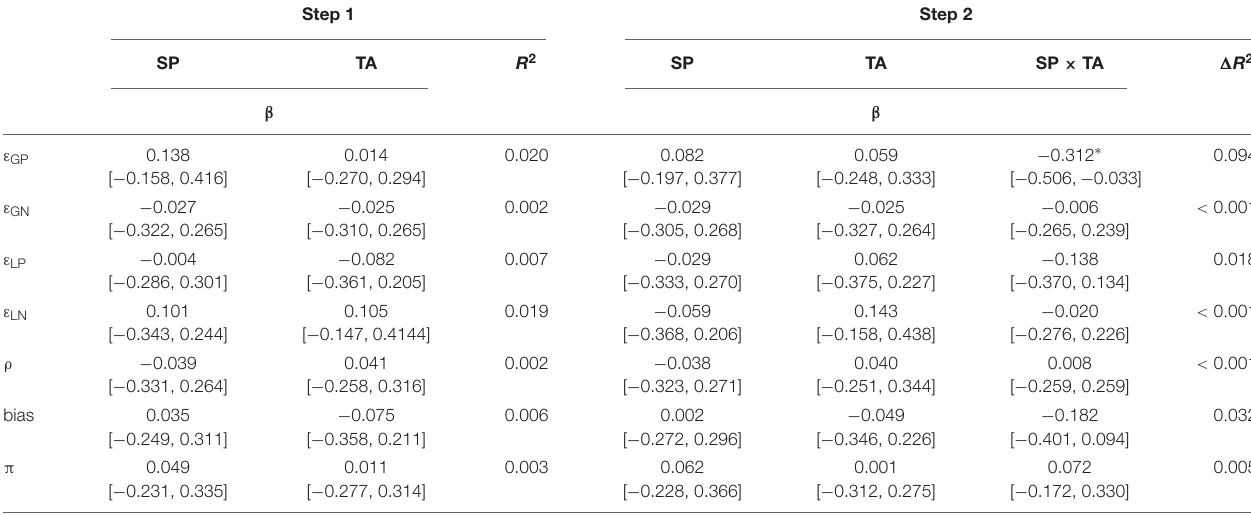
TABLE 5 | Results of hierarchical regression analyses for each learning parameter predicted by secondary psychopathy and trait anxiety scores. Step